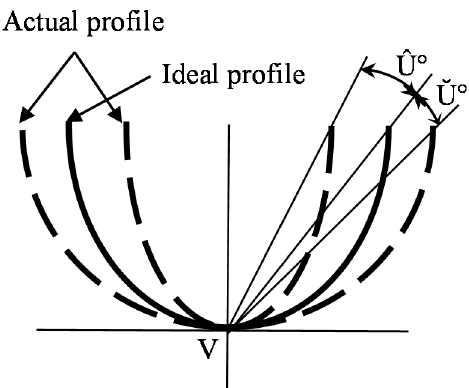
Figure 12. Actual profile versus ideal profile of a parabolic mirror. In the figure, V is the vertex of the parabola, and Û° and Ŭ ° are the inward and outward angular rotation of two halves of the mirror with respect to the vertex from its ideal profile respectively.